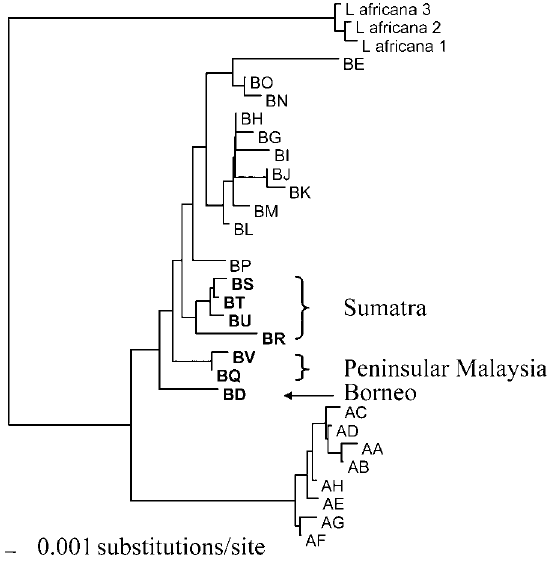
Figure 3. A Neighbour-Joining Phylogram of Asian Elephant Haplotypes Rooted with an African Elephant Out-Group Sunda Region haplotypes are in bold. DOI: 10.1371/journal.pbio.0000006.g003